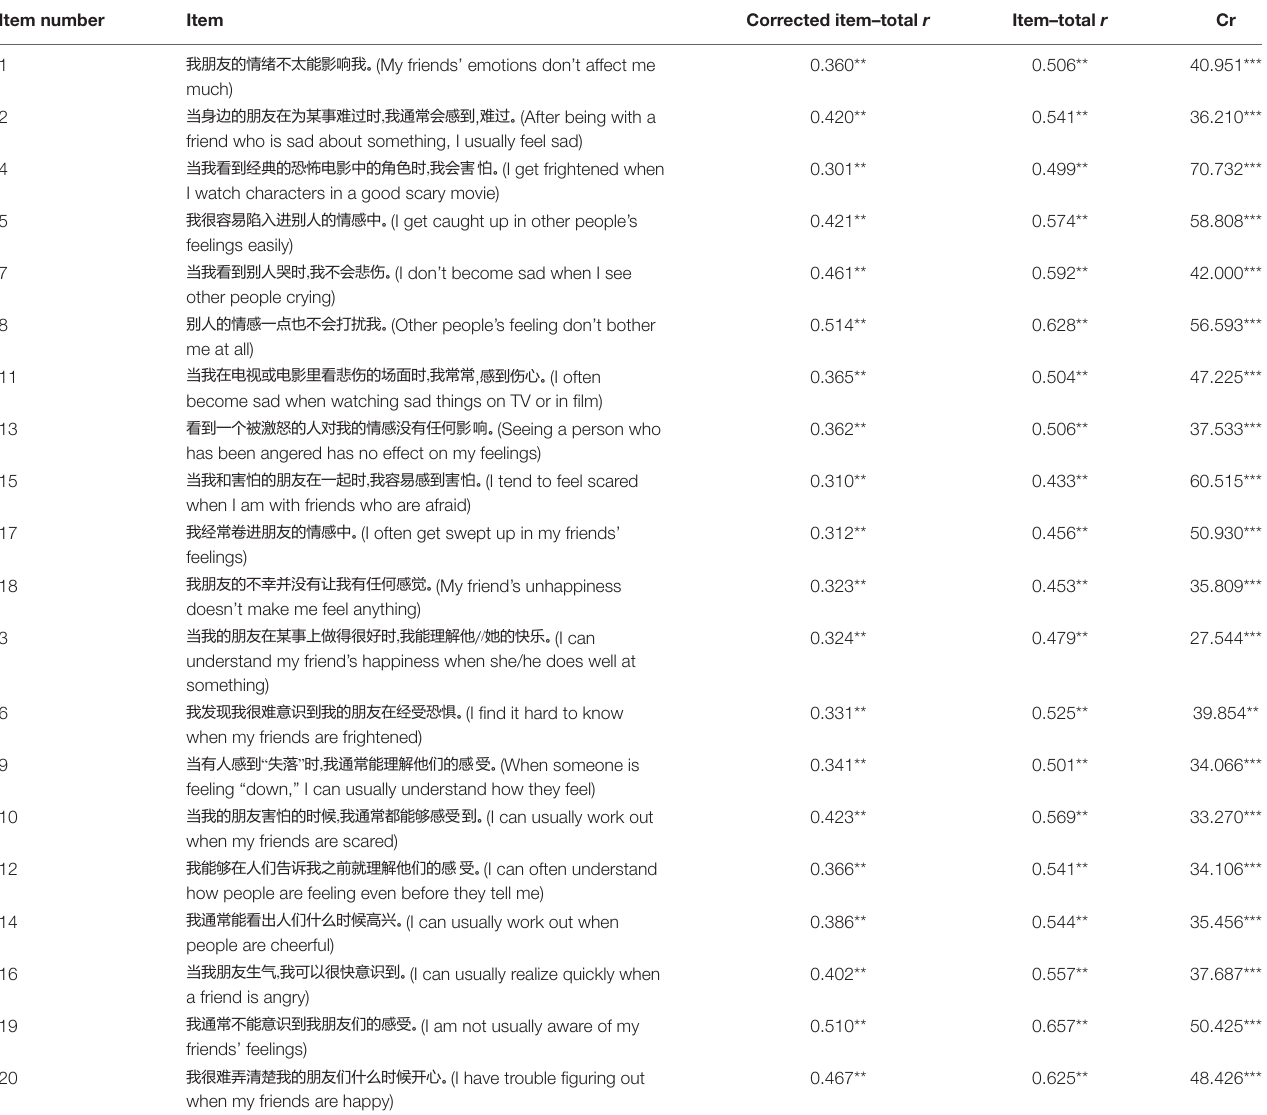
TABLE 1 | Corrected item–total r, the item–total r, and Cr value.